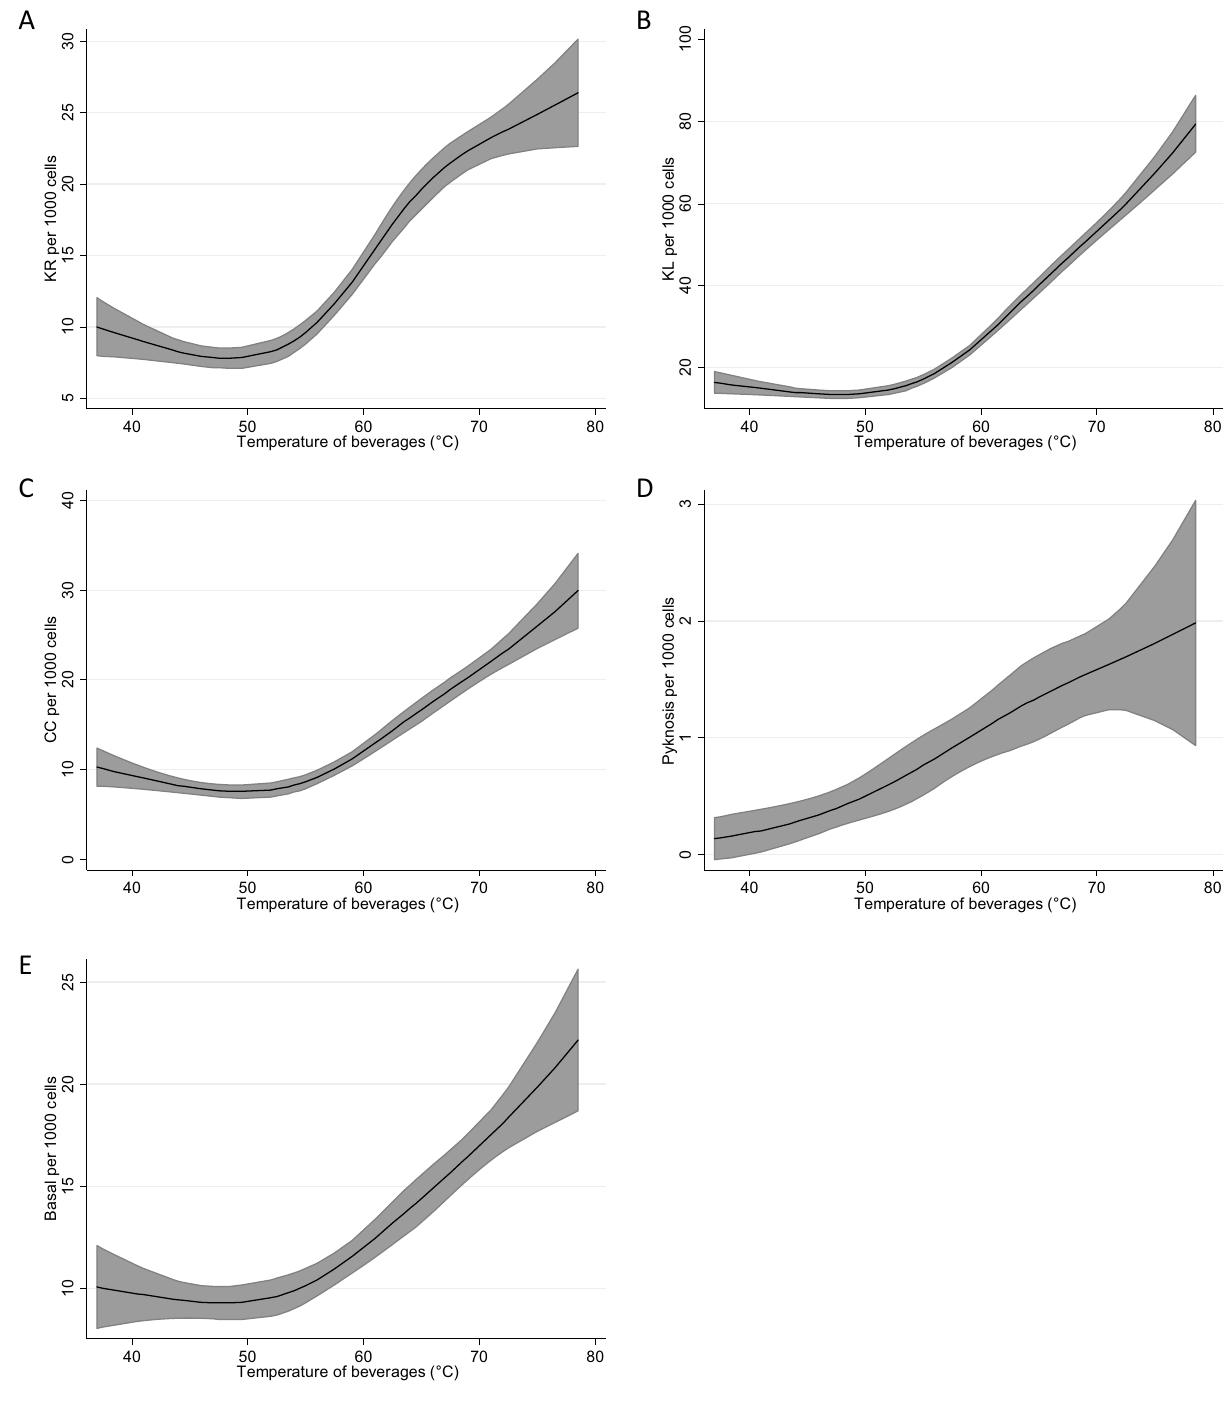
Figure 2. ( A – E ) Estimated number (and 95% confidence intervals) of cellular anomalies and basal cells as a function of the average temperature of beverages. Estimation by Poisson regression with restricted cubic splines ( KR karyorrhexis, KL karyolysis, CC condensed